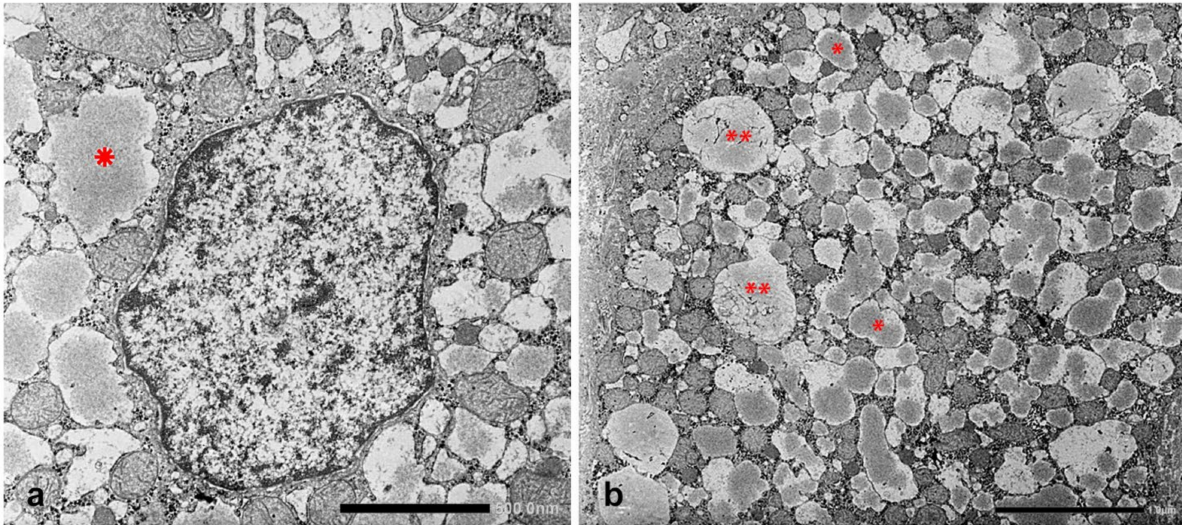
Figure 8. PiMZ phenotype patient. The electronmicrophotograph shows a periportal hepatocyte with dilated cisternae of the RER containing amorphous fluffy AAT material (*). RER membranes are in close contact with mitochondria ( a ) (EM × 15.725). The electronmicrophotograph shows a large cytoplasmic portion of a hepatocyte with diffuse dilatation of ER cisternae. Most of the AAT-like material appears in the form of amorphous semi-electron dense material (*). A few inclusions present a dense, compact appearance and entrapped remnants of disrupted membranes (**) ( b ) (EM ×